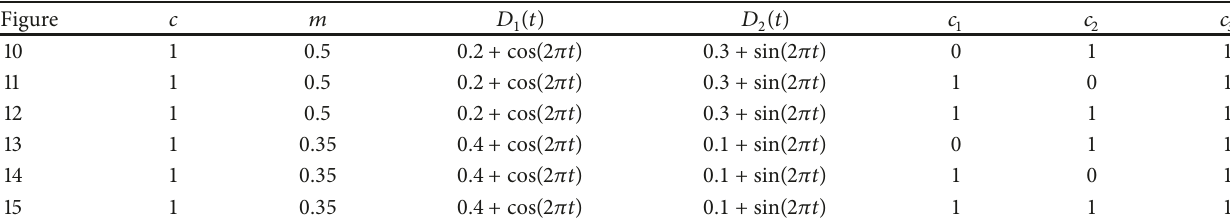
Table 2: Parameters used in Experiment